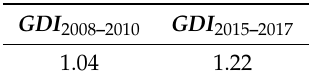
Table 6. A comparison of GDI before and after the implementation of Gelmini reform (MIUR data) (Picardi 2019).